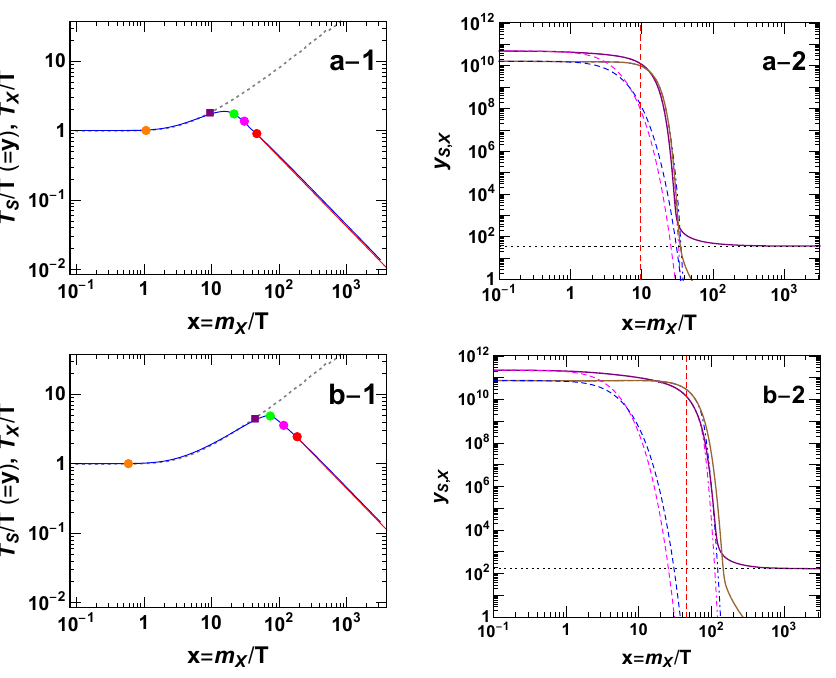
Figure 4 . Same as (cid:12)gure 3, but using (cid:11) = 5 (cid:2) 10 (cid:0) 7 , and 1 (cid:2) 10 (cid:0) 7 for (a), and (b), respectively. non-zero if the hidden scalar undergoes an out-of-equilibrium decay before the DM freezes out (see (vi) for related discussions). In the right panel of (cid:12)gures 3, 4, and 5, the dashed curves exhibit the results with the Boltzmann suppression (i.e., with (cid:22) = (cid:22) = 0) for the hidden sector if T = T , X S X;S while dot-dashed curves follow the Boltzmann suppression at their true tempera- tures, where curves in magenta and blue colors are for the DM and hidden scalar,